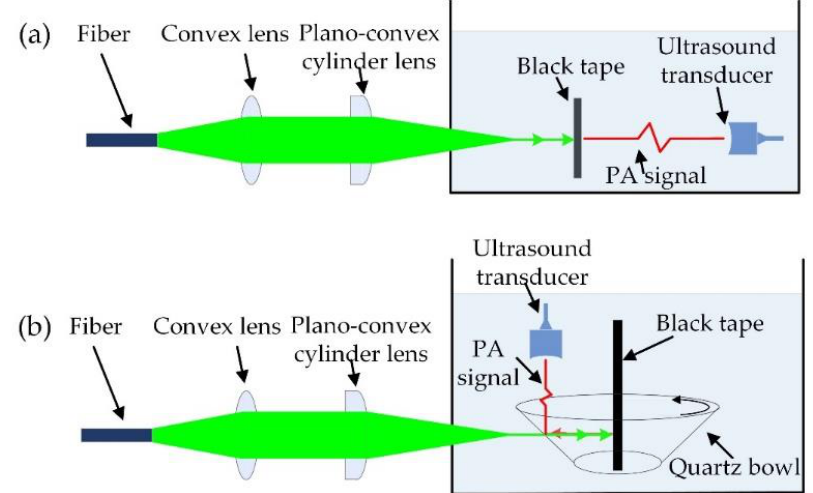
Figure 4. ( a ) Schematic diagram of photoacoustic imaging device in ultrasonic transmission mode. ( b ) Schematic diagram of photoacoustic imaging device in ultrasonic reflection mode.